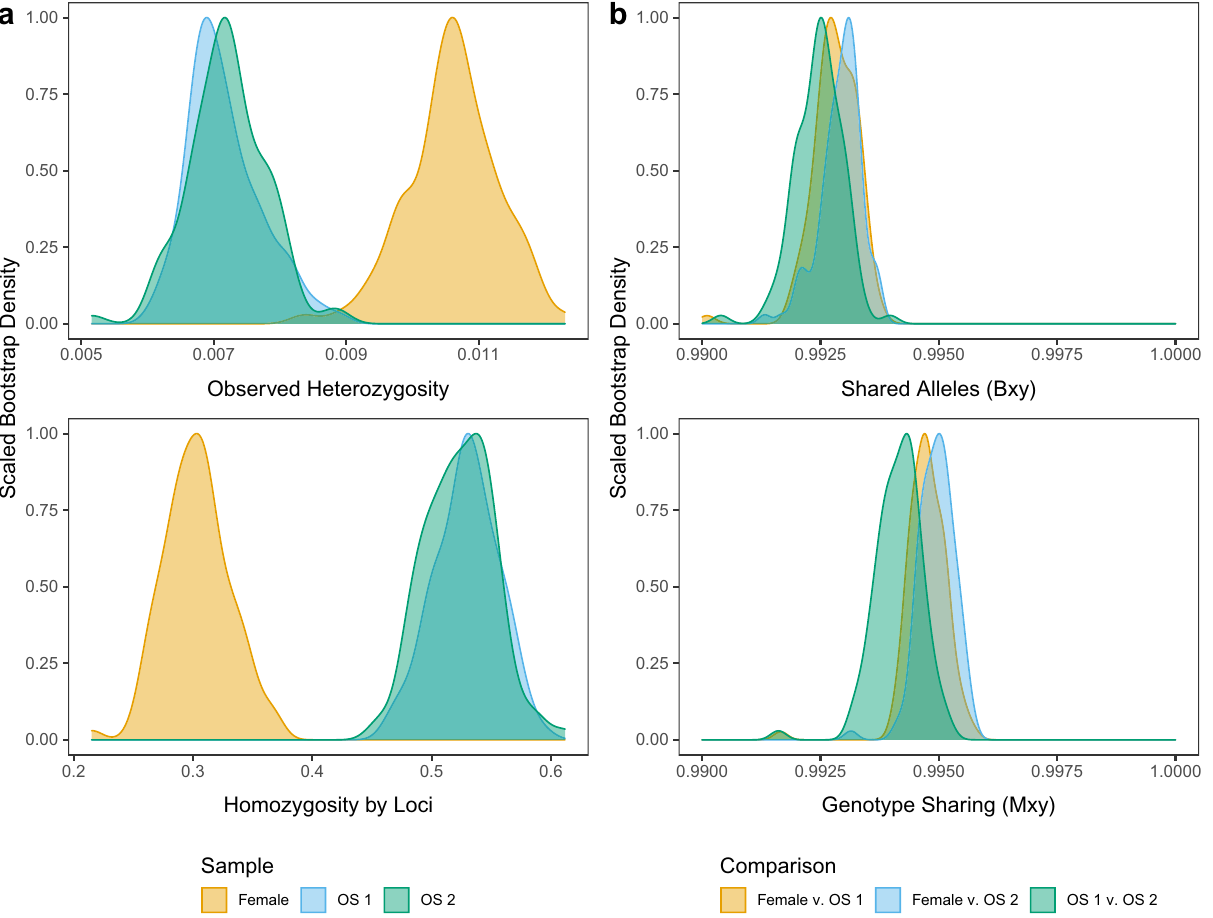
Figure 2. ( a ) Bootstrap densities of two measures of individual heterozygosity for each member of the cobra family (female = mother, OS 1 = offspring 1, OS 2 = offspring 2) based on 100 bootstrap replicates of 20,562 independent RAD loci: (top) Proportion of heterozygous sites (Observed Heterozygosity), and (bottom) the standardized level of homozygosity (Homozygosity by Loci). ( b ) Bootstrap densities of two measures of pairwise relatedness between the mother and each parthenogenetic offspring based on 100 bootstrap replicates sampled variants: (top) shared alleles index ( B xy ) and (bottom) genotype sharing index ( M xy ). Sexual reproduction would produce measures at